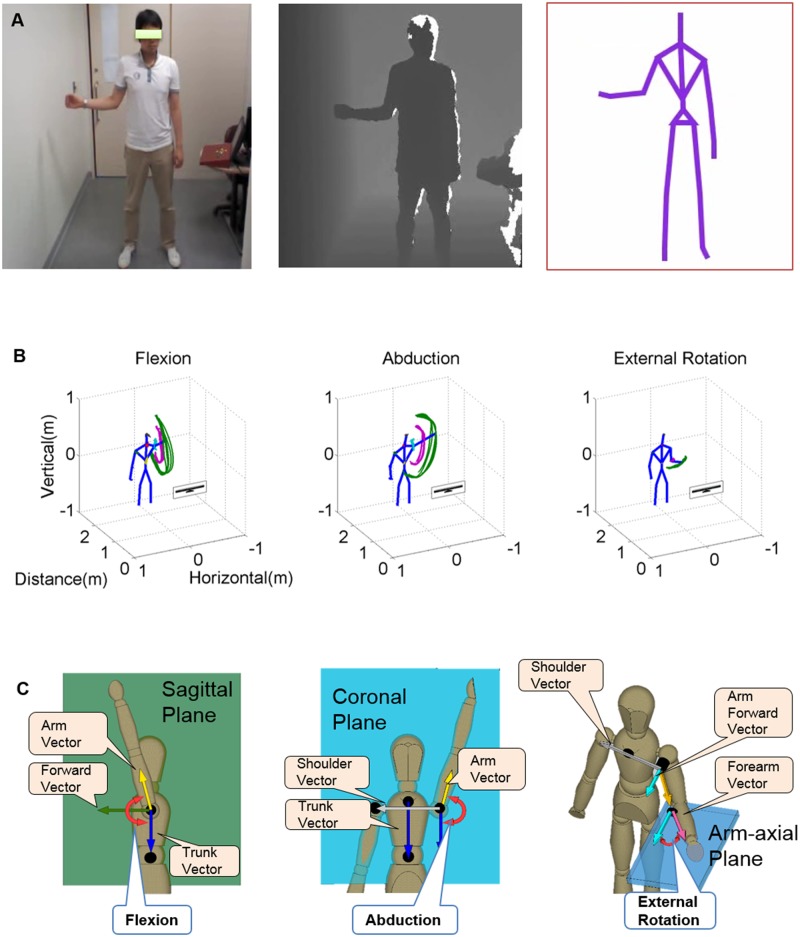
Measurement and calculation of the shoulder range of motions (ROMs) using the Kinect.A. Red, green, and blue image, depth image, and converted skeleton image from the Kinect. B. Traces of body segments during each shoulder motion. The green line is the trace of the left wrist, while the pink line is the trace of the left elbow. C. Calculation of the shoulder ROM angles by the projected angles on the defined anatomical planes. The individual in this figure has given written informed consent (as outlined in PLOS consent form) to publish these case details.